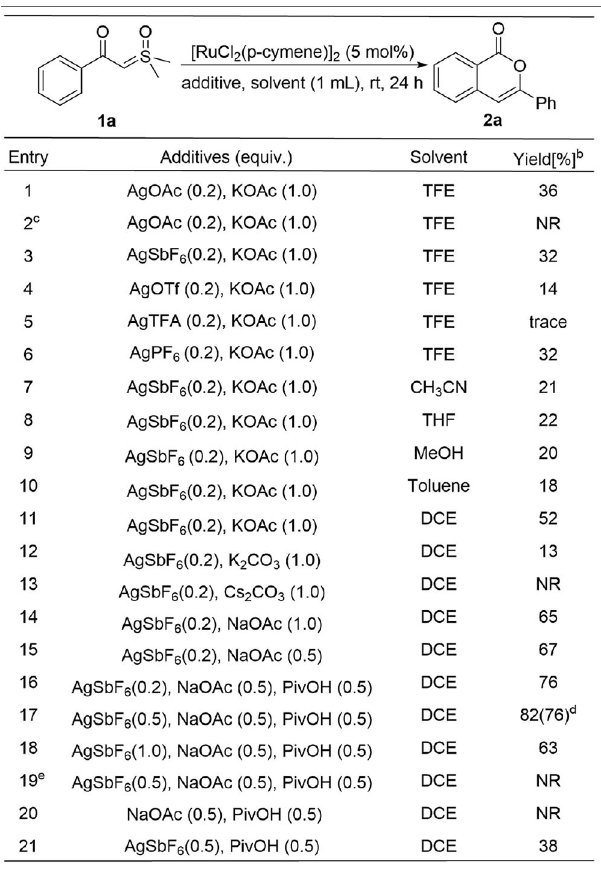
TABLE 1 | Optimization of reaction conditions a